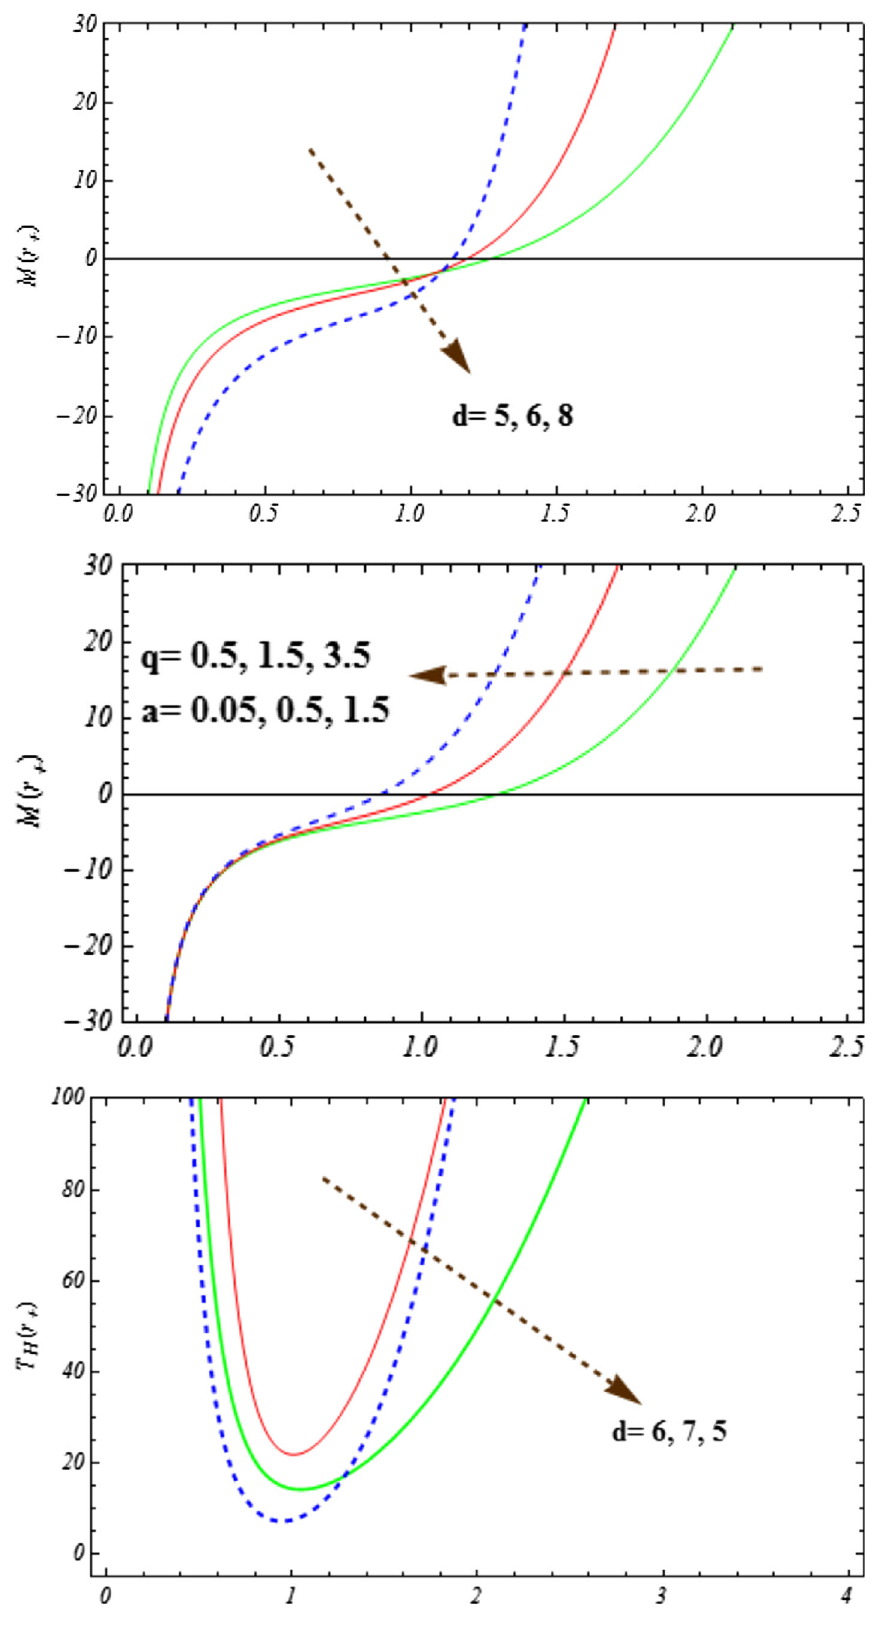
Fig. 3 The plot of mass M (Eq. (3.1)) vs r + for chosen values of l = 1, δ d , 2 n − 1 = 100, ω = − 0 . 5, (cid:13) = 1, q = 0 . 5, q d − 2